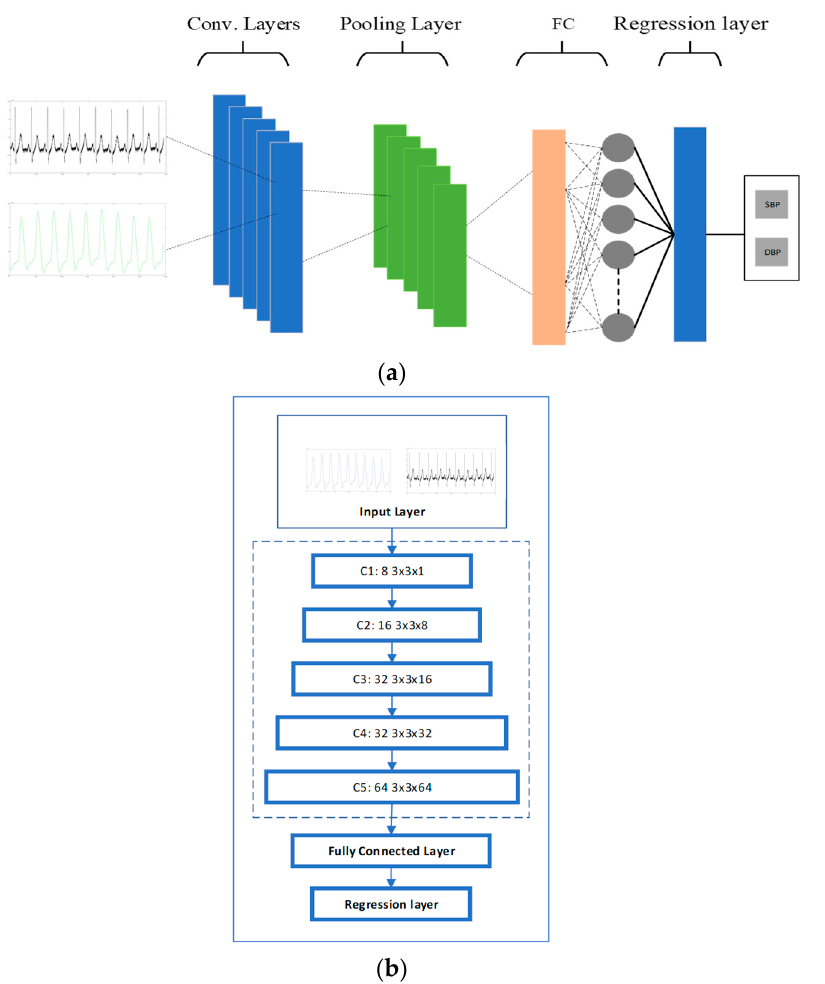
Figure 5. ( a ) CNN structure; ( b ) CNN